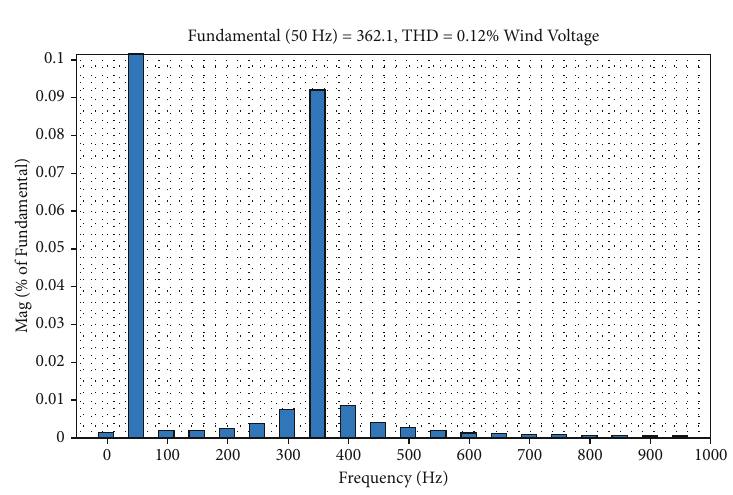
Figure 36: THD values of wind voltage.